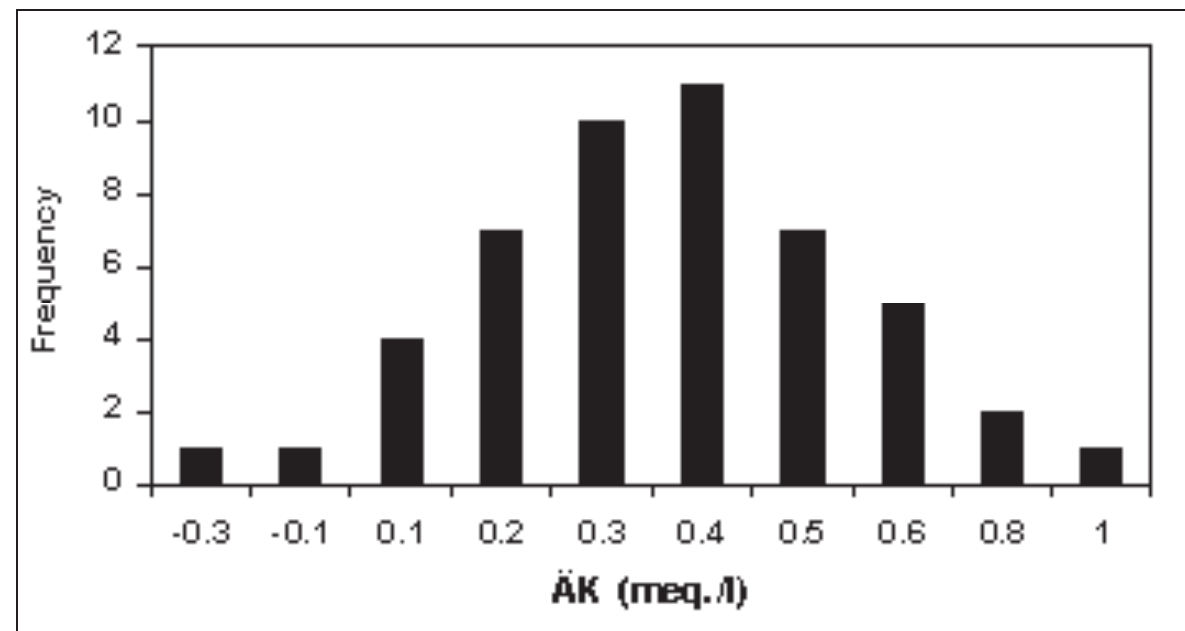
Fig. 3: Frequency distribution of variation potassium values in replicate smaples following 24 hours of serum-clot